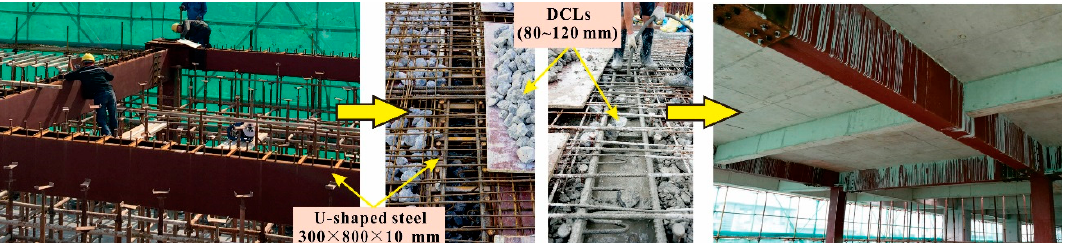
Figure 1. Practical application of U-shaped steel beams filled with DCLs and FC.